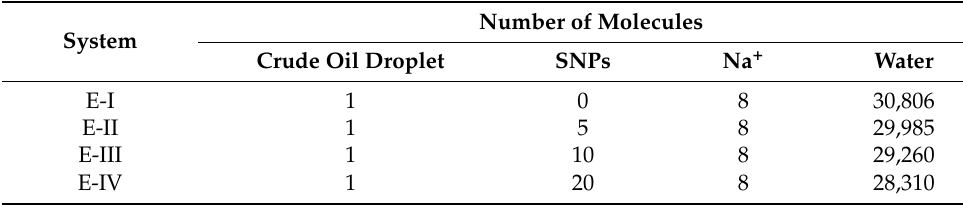
Table 1. Details of the emulsified oil droplet systems containing SNPs.